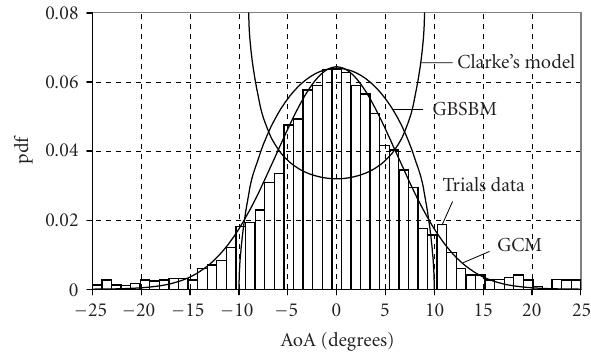
Figure 3: The PDFs for the AoA of the multipath components at the BS for GCM, GBSBM, Clarke’s models, and for the measured